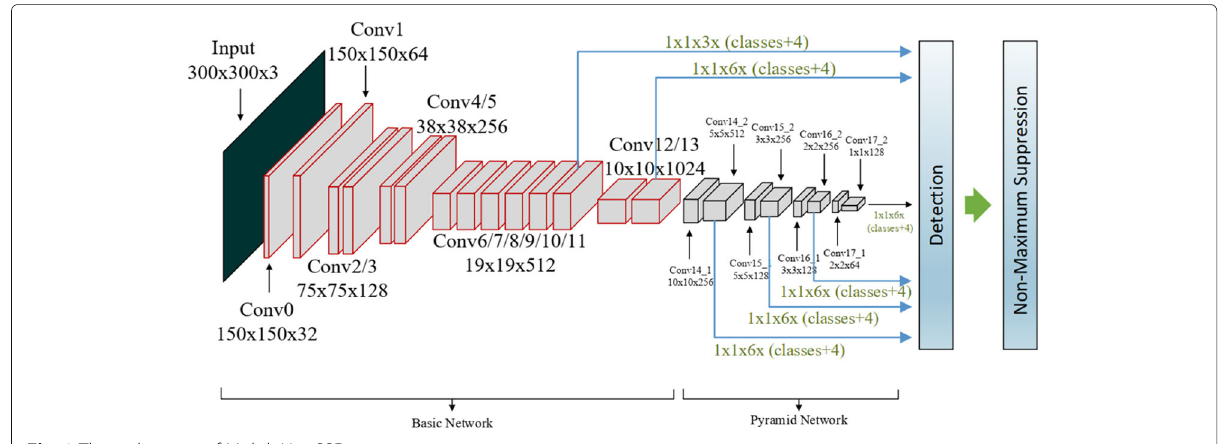
Fig. 2 The architeture of MobileNet-SSD and light, the data collected directly by the camera often have problems such as the target being blocked or too small, insufficient brightness or overexposure, excessive noise, and images from a single angle, which can seriously affect the recognition accuracy. To reduce the influence of the above factors, we analyze 9963 pictures collected from elevators in depth, of which 18% are collected from com- mercial mixed-use apartment elevators and 82% are from residential building elevators, and propose the use data